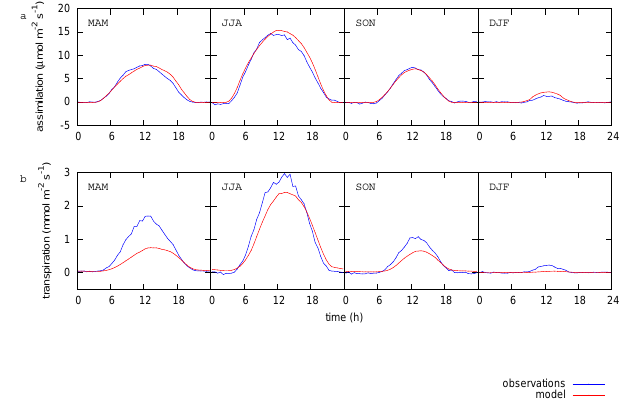
Figure 3. Diurnal cycle of simulated and observed (a) CO 2 assim- ilation and (b) transpiration, averaged for four seasons with data from 1999, 2000 and